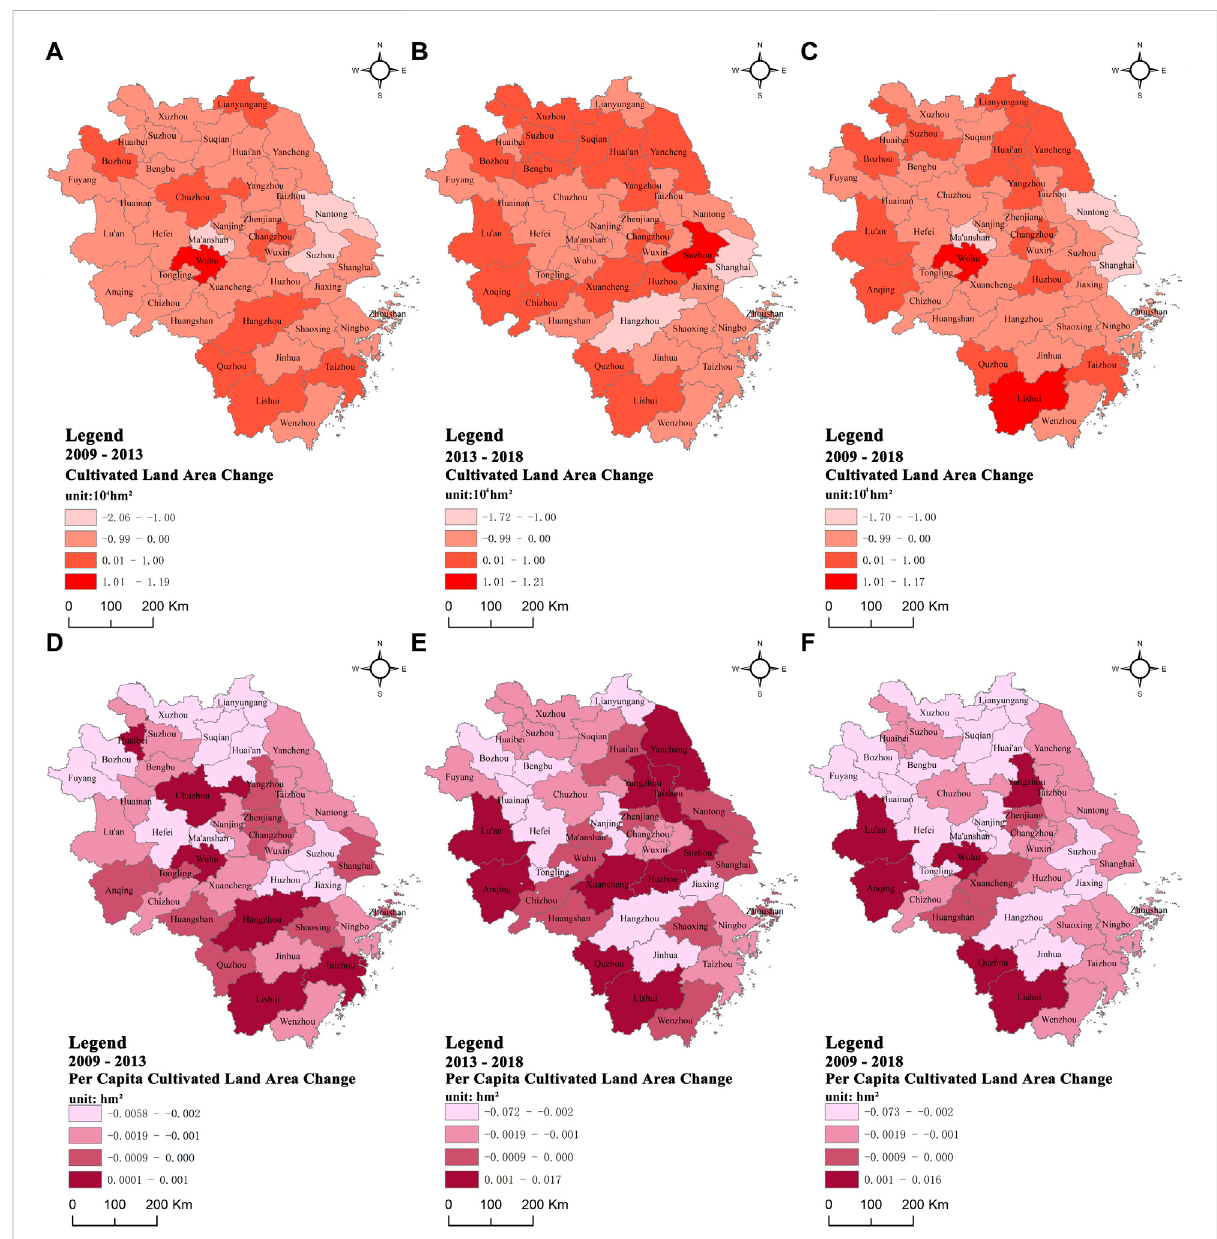
FIGURE 5 Changes in cultivated land area and per capita cultivated land area in different periods. (A-C) represent cultivated land area change in 2009-2013, 2013-2018,and2009-2018,respectively. (D-F)